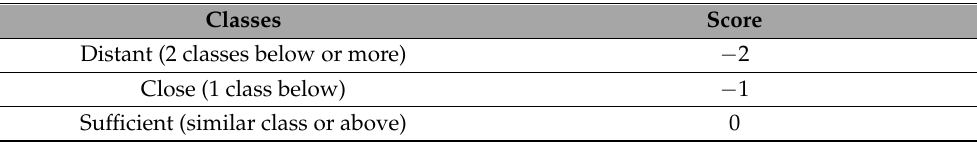
Table 11. TP ds,pa —temporal pertinence. Classes